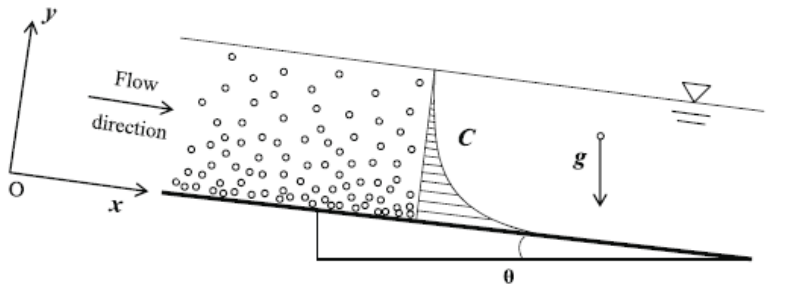
Figure 1. Sediment Concentration Profile. Reprinted with permission from [1]. 2021 Hanmaiahgari, P.R.